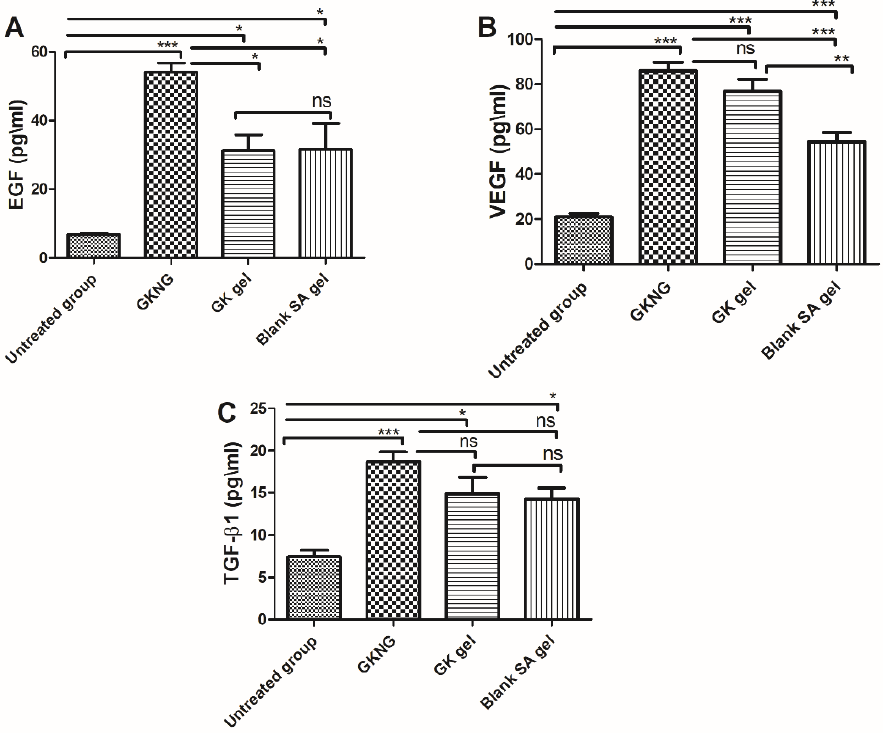
Figure 7. Effects of GKNG, GK gel, and blank SA on the angiogenic markers ( A ) EGF, ( B ) VEGF, and ( C ) TGF- β1. Values are represented as mean ± SD (n = 4). Statistical analysis was performed by one-way ANOVA followed by Tukey’s multiple comparison test. ‘***’, ‘**’, and ‘*’ refer to p < 0.001, p < 0.01, and p < 0.05 and represent significant differences between the treatment and untreated groups. ‘ns’ refers to a nonsignificant difference between the treatment groups and untreated groups.